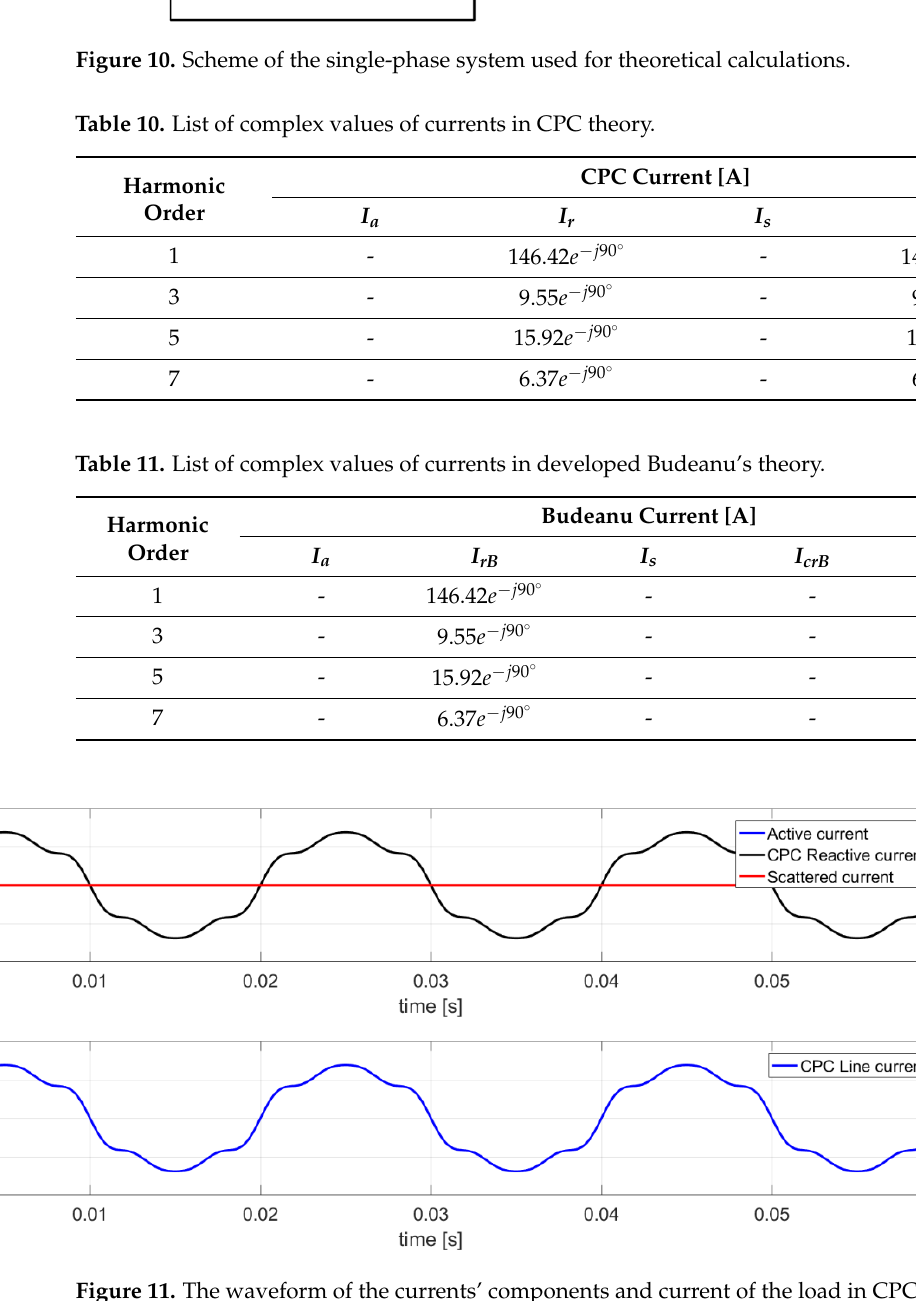
Figure 11. The waveform of the currents’ components and current of the load in CPC theory.